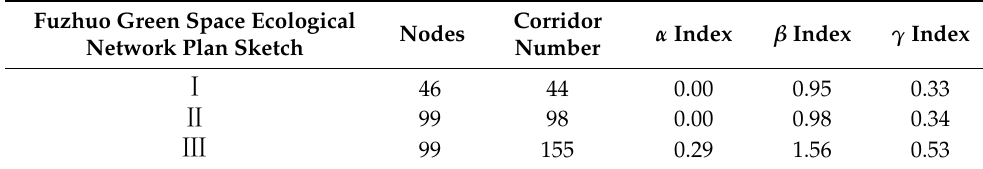
Table 7. Corridor structure index and network structure index.